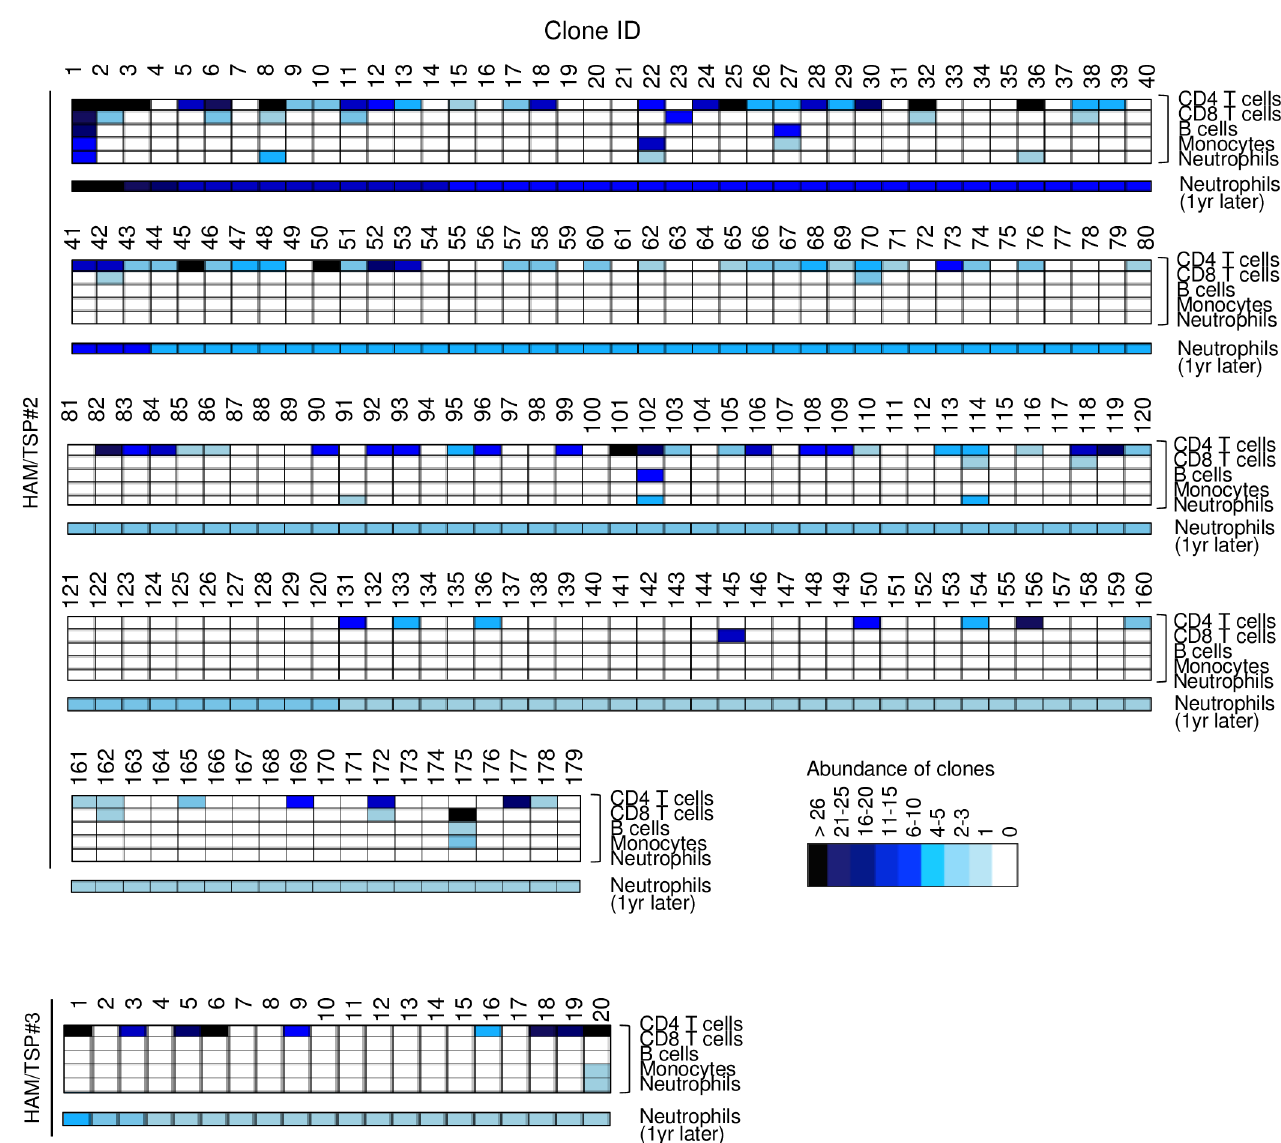
Fig 5. Persistence of HTLV-1 infected clones in HAM/TSP patients at different time point. HTLV-1 integrationsites are determinedusing high throughput sequencing using genomicDNAs from neutrophilsone year later in two HAM/TSP patients. The cell number of each clone is demonstrated by color. The longitudinalcolumn represents the same integration